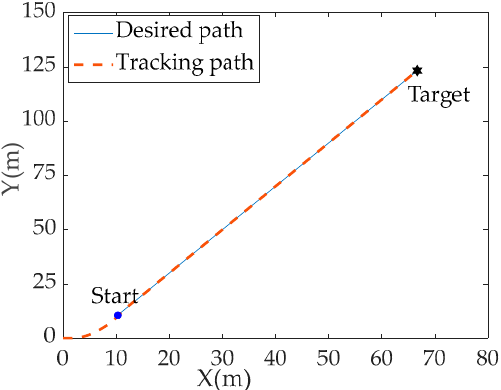
Figure 8. Path tracking results for the straight line.